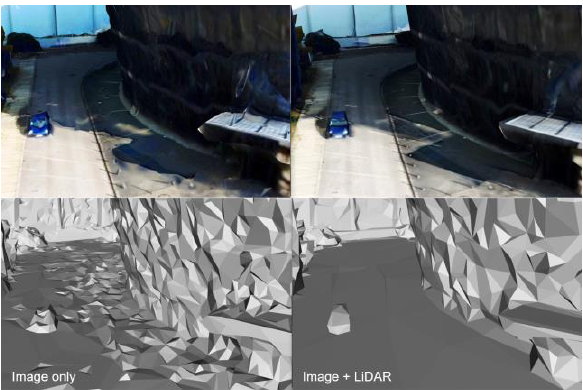
Figure 15: Comparison of 3D Mesh from image only (left) and image + LiDAR (right) approach. 3D mesh generated by Melown technologies from CityMapper-2 data, 5 cm GSD